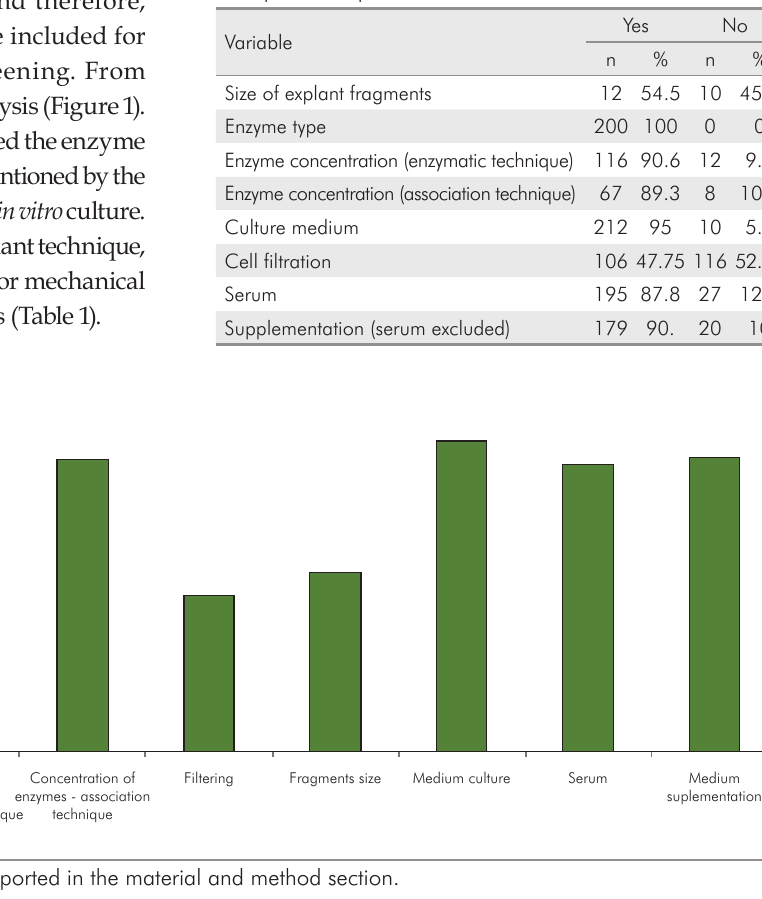
Table 1. Distribution according to the presence or absence of important aspects of DPSCs